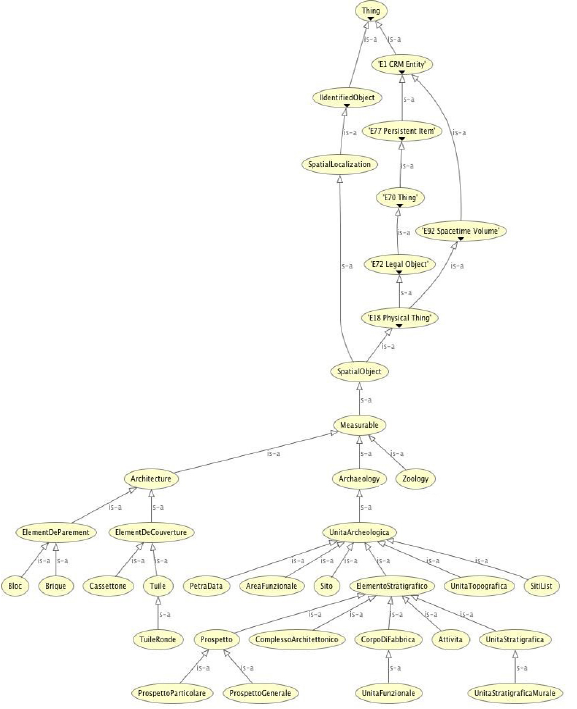
Figure 4. Partial ontology visualization with CIDOC CRM aligmenent.